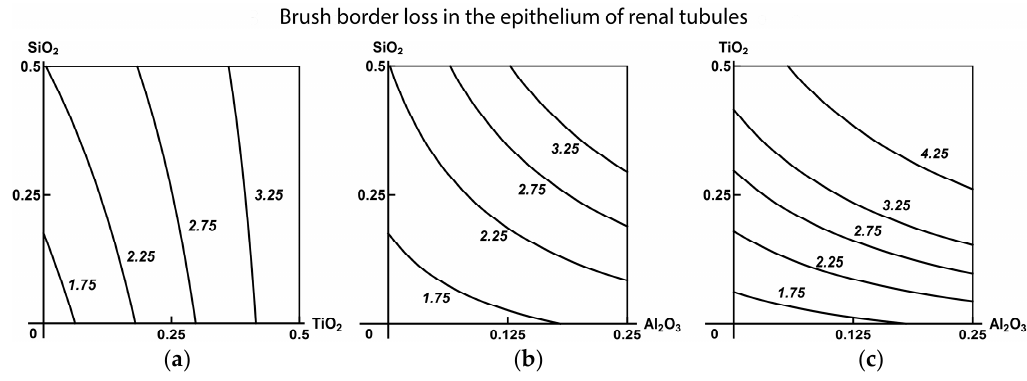
Figure 6. Isobolograms of combined subchronic toxicity assessed by brush border loss in the epithelium of renal tubules: ( а ) SiO 2 -NP + TiO 2 -NP (single-factor effect of TiO 2 -NP with insignificant additivity); ( b ) SiO 2 -NP + Al 2 O 3 -NP (additivity tending towards synergism); ( c ) TiO 2 -NP + Al 2 O 3 -NP (the same type of action). The axes represent doses of corresponding МеО -NPs in mg per rat. The numbers at the isoboles denote the magnitude of the effect (expressed in %—see the text).